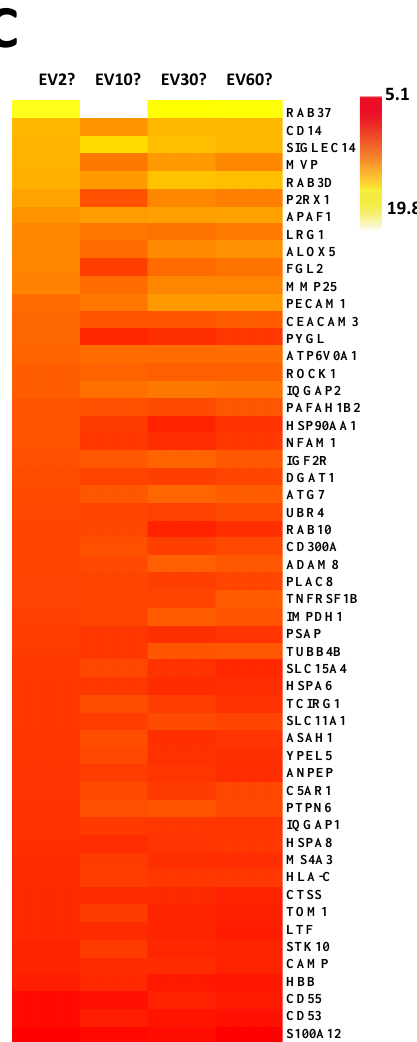
Figure 3. ( A ): Hierarchical clustering heatmap representing differential gene expression between neutrophils at 2′ and 30′ and neutrophils treated with EVs from CM 61 cell line. The sample represented as “Neu/EVs” denotes a biological duplicate. The Log2 fold changes are represented here ranging from a maximum of 4.5 fold to a low of 1.5 fold. The top differentially expressed genes are shown on the right; heatmap of gene expression of constituent genes in ( B ) reteplase and ( C ) neutrophil degranulation pathways with basal levels shown as Neu 2′ and neutrophils treated with EVs at different time points (EVs 10′, EVs 30′, and EVs 60′).